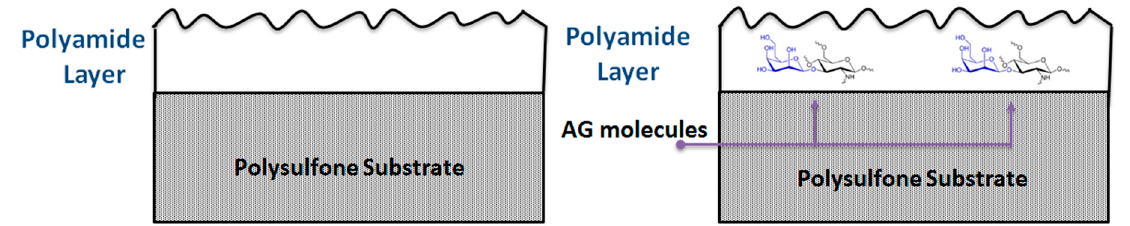
Figure 1. Schematic showing the incorporation of AG inside the top layer of the PA TFC Figure 1 . Schematic showing the incorporation of AG inside the top layer of the PA TFC membrane.